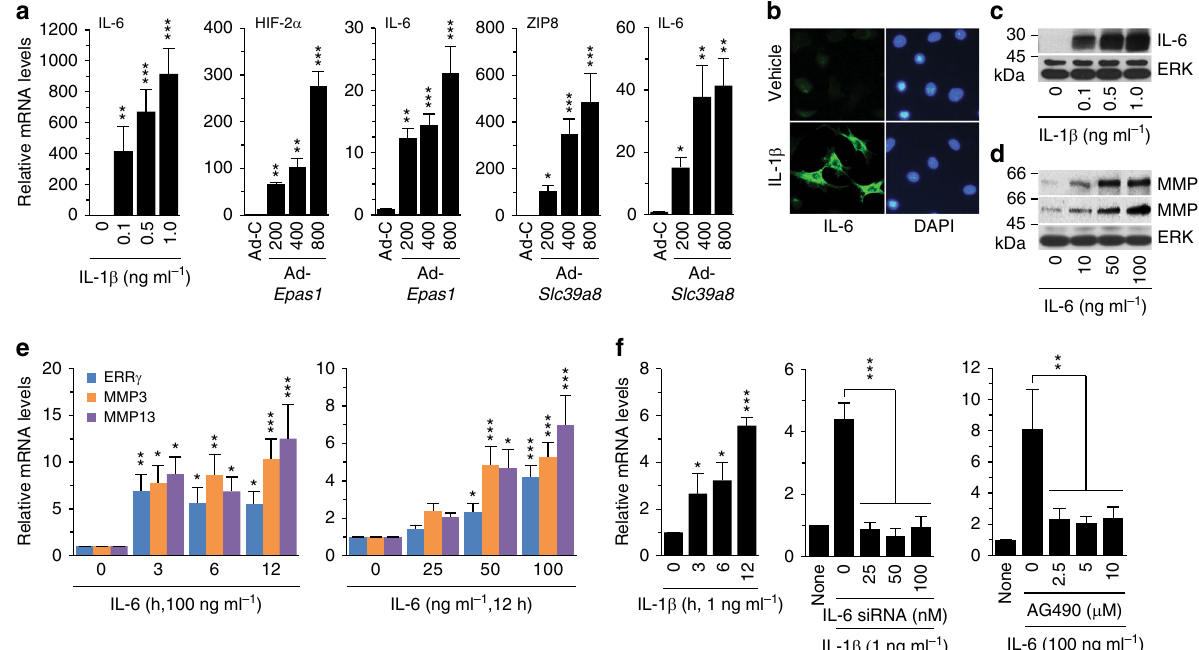
Fig. 2 Signaling upstream of ERR γ expression. a qRT-PCR analysis ( n ≥ 8) of IL-6 in chondrocytes treated with IL-1 β and infected with 800 MOI of control virus (Ad-C) or the indicated MOI of Ad- Epas1 or Ad- Slc3918 . b , c Detection of IL-6 in chondrocytes treated with IL-1 β (1 ng ml – 1 ) by immuno fl uorescence microscopy ( b ) and Western blotting ( c ). d , e Western blot ( d ) and qRT-PCR ( e ) analysis of ERR γ , MMP3, and MMP13 in chondrocytes treated with IL-6 ( n = 10). MMP3 and MMP13 proteins in conditioned medium of chondrocyte cultures were detected by Western blotting. f qRT-PCR analysis ( n ≥ 8) of ERR γ mRNA levels in chondrocytes treated with IL-1 β (left panel). qRT-PCR analysis ( n ≥ 8) of ERR γ mRNA levels in chondrocytes treated with IL-6 siRNA and exposed to IL-1 β (middle panel). qRT-PCR analysis ( n ≥ 8) of ERR γ mRNA levels in chondrocytes treated with AG490 and exposed to IL-6 (right panel). Values are presented as means ± s.e.m. (* P < 0.05, ** P < 0.005, and *** P < 0.0005. One-way